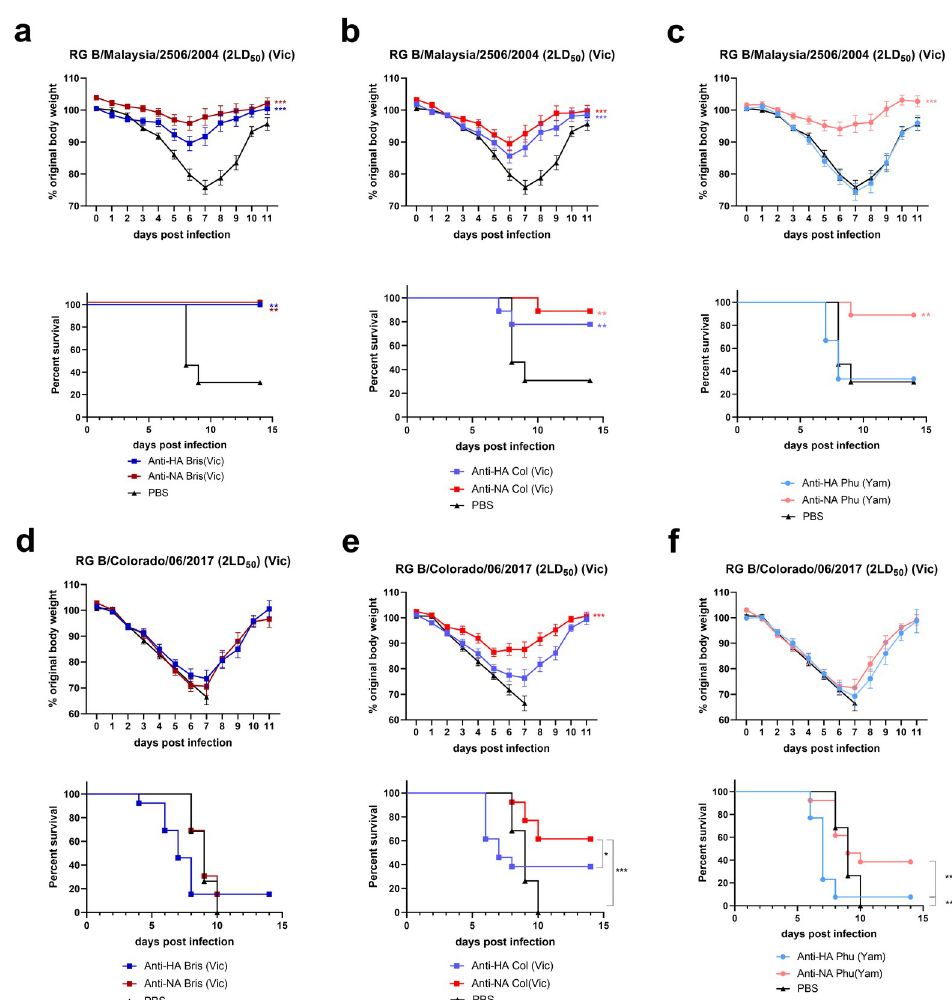
Fig 3. Cross protection induced by serum transfer against representative Victoria lineage viruses. Mice received 16 μ l of serum raised against tetNA and HA from B/Brisbane/60/2008 (a and d), B/Colorado/06/2017 (b and e), or B/ Phuket/3073/2013(c and f). One day after intraperitoneal injection of the sera, the mice were challenged intranasally with 2LD 50 of RG B/Malaysia/2506/2004, and weight loss and mortality were determined, experiment was repeated twice with 4–5 mice per group (a-c). Morbidity and mortality were also determined in mice challenged with RG B/ Colorado/06/2017. The experiment was repeated 3 times with 4–5 mice per group (d-f). Relative body weight values were analyzed as repeated measurements using method of residual maximum likelihood (REML). Survival analysis was done by the log-rank (Mantel-Cox) test. Significances: �� P < 0.01; ��� P < 0.001. The PBS group refers to data pooled from mice that received PBS or serum from na ï ve mice prior to challenge. All groups receiving serum transfer were tested simultaneously against each challenge, but for clarity the weight loss and survival curves were split in distinct graphs. As a consequence, the PBS control data is repeated.